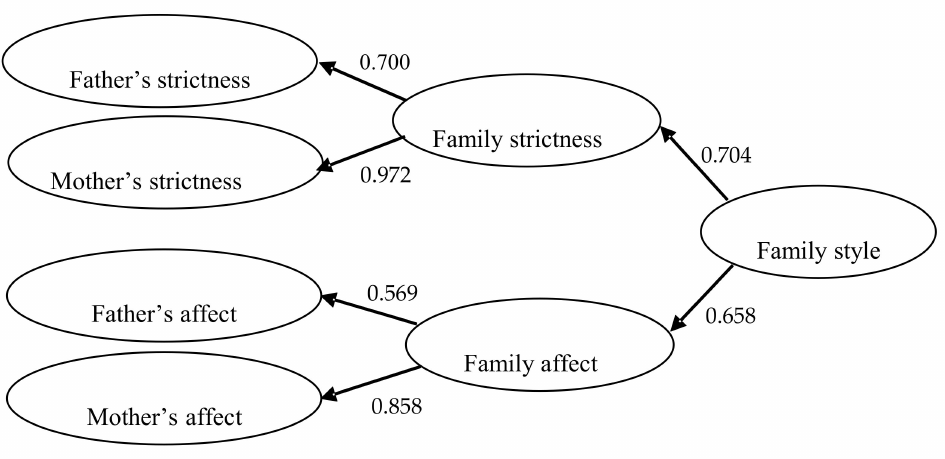
Figure 2. Standardized solutions of the accepted M3